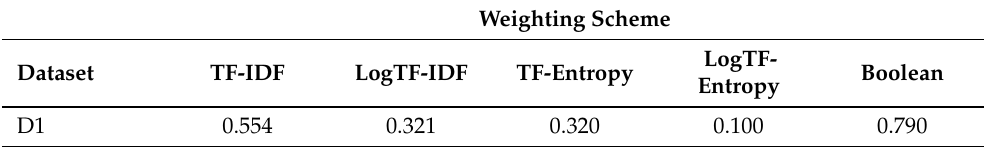
Table 16. Adjusted Rand index for Dataset D1.